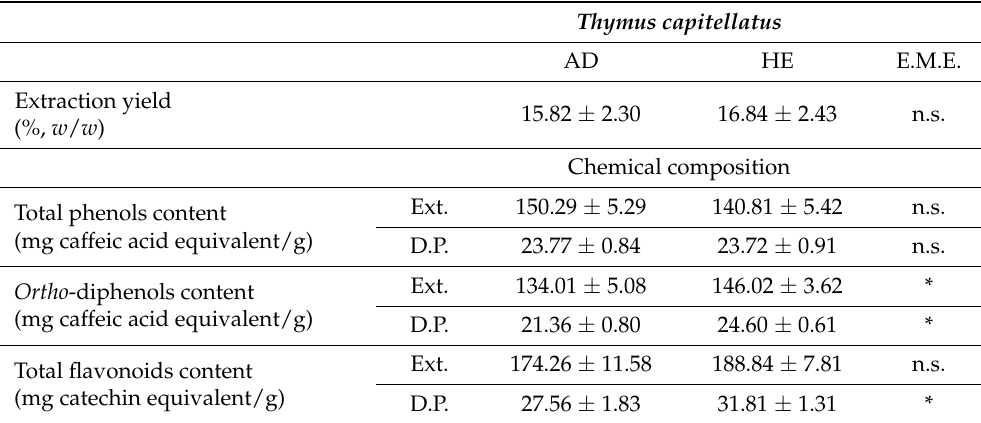
Table 1. Extraction yields, chemical composition and ABTS radical scavenging activity of Thymus capitellatus